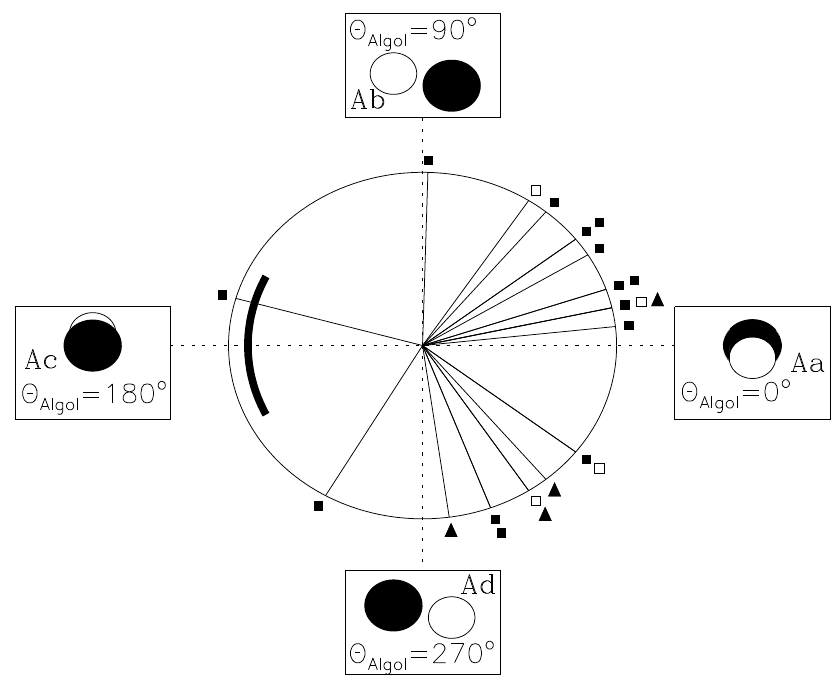
Figure 1. Θ Algol phase angles of lucky time points of Table 1. Time runs in the counter-clockwise direction on this circle. Epochs Aa, Ab, Ac and Ad are separated by 90 degrees and they are denoted with dotted straight lines. The relative locations of Algol A (white disk) and Algol B (black disk) at these four epochs are shown in the small boxes. Primary and secondary eclipses of Algol occur at Ac and Aa, respec- tively. The thick curved line centered at Ac outlines the phase angles of the 10 hour primary eclipse of Algol at 153.7 o < Θ Algol < 206.3 o . The phase angle values Θ Algol of “Horus” (closed squares), “Wedjat” (open squares) and “Sakhmet” (closed triangles) are denoted with continu- ous straight